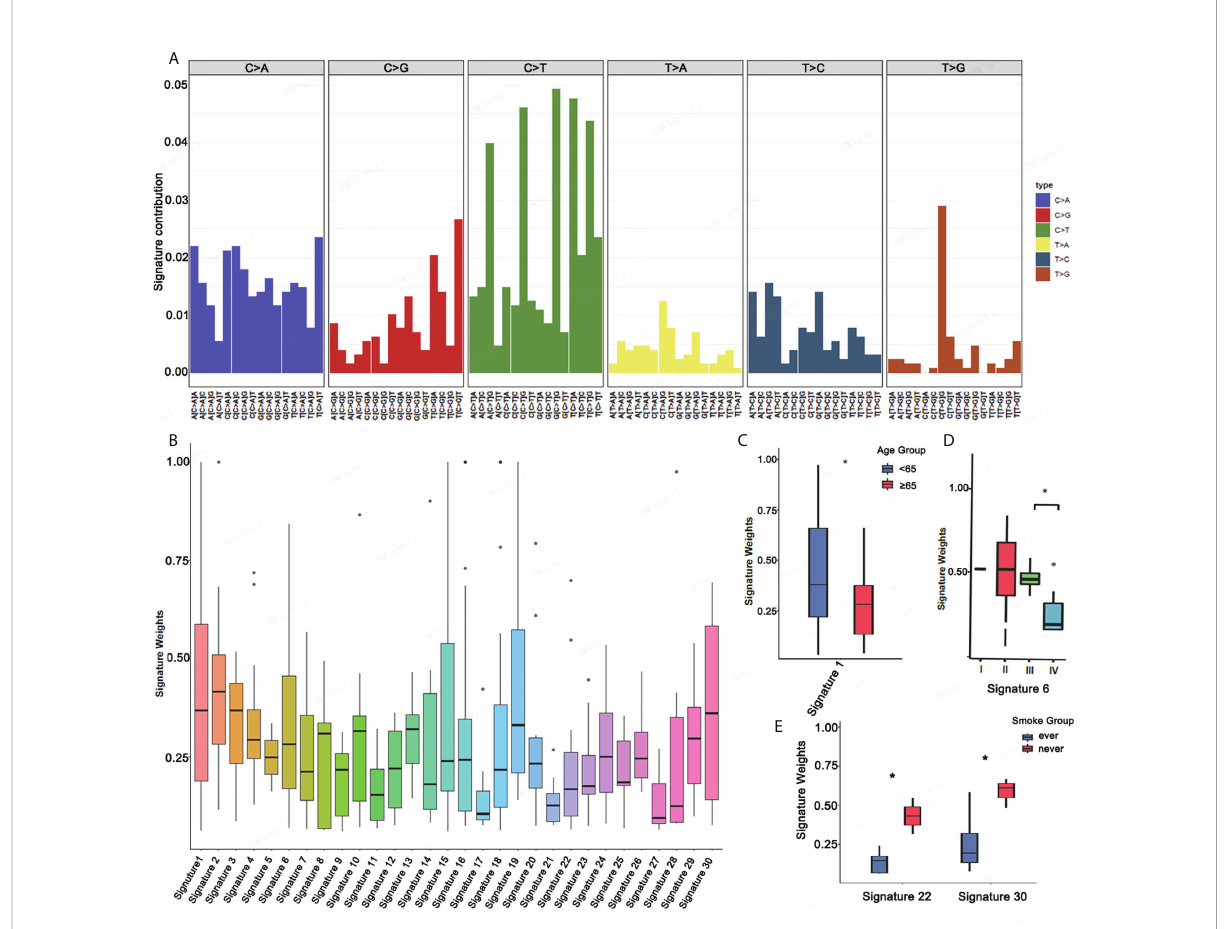
FIGURE 3 Mutational signatures in ASC patients. (A) Mutational activities for the corresponding extracted mutational signatures. (B) Mutational activities for the corresponding displayed mutational signatures. (C – E) The association between mutational signature and age, stage, and smoking *p